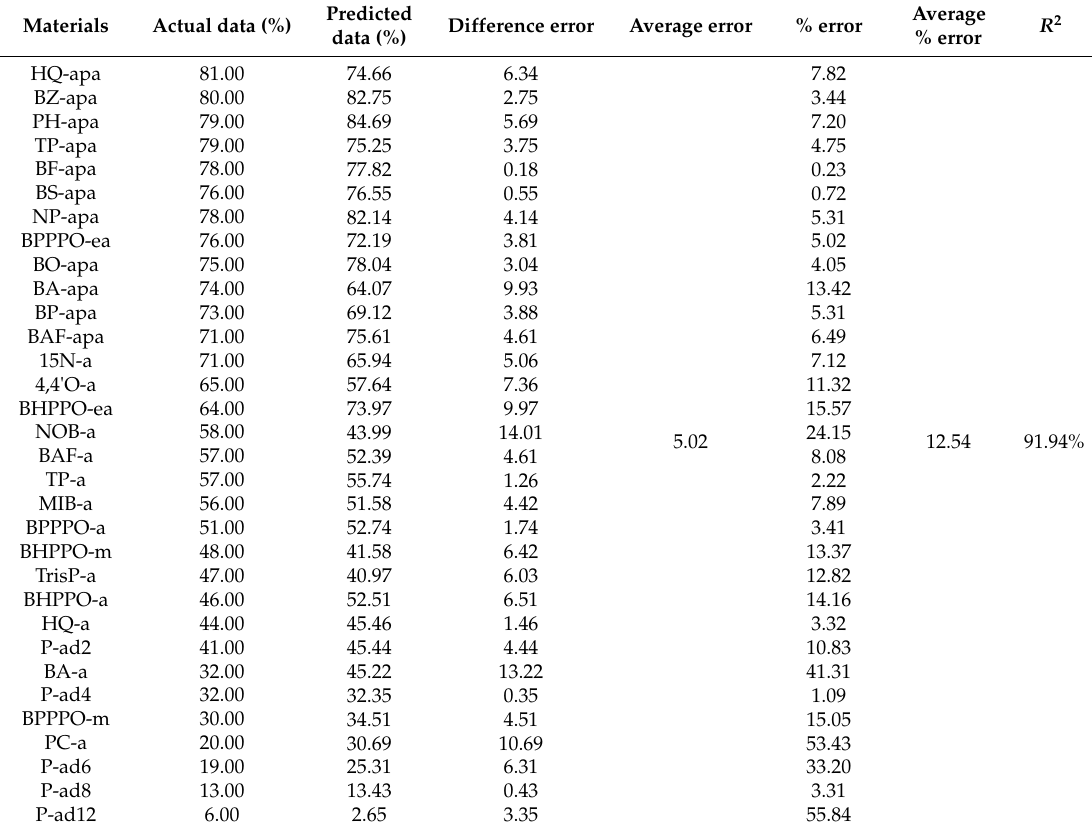
Table 6. Prediction data, calculated average error and average percentage error for lowest energy conformation quantitative structure property relationships (QSPR) model.